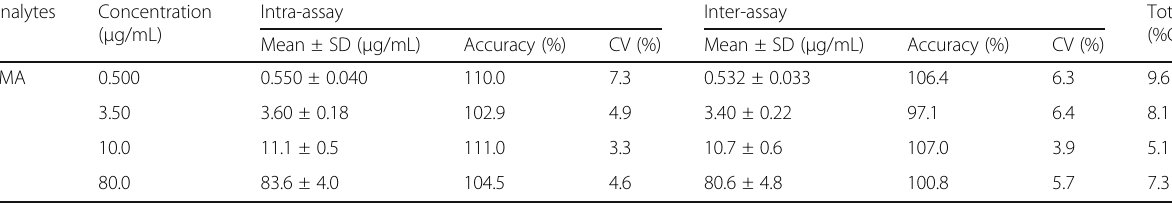
Table 1 Intra-assay, inter-assay accuracy, and imprecision for VMA in human urine